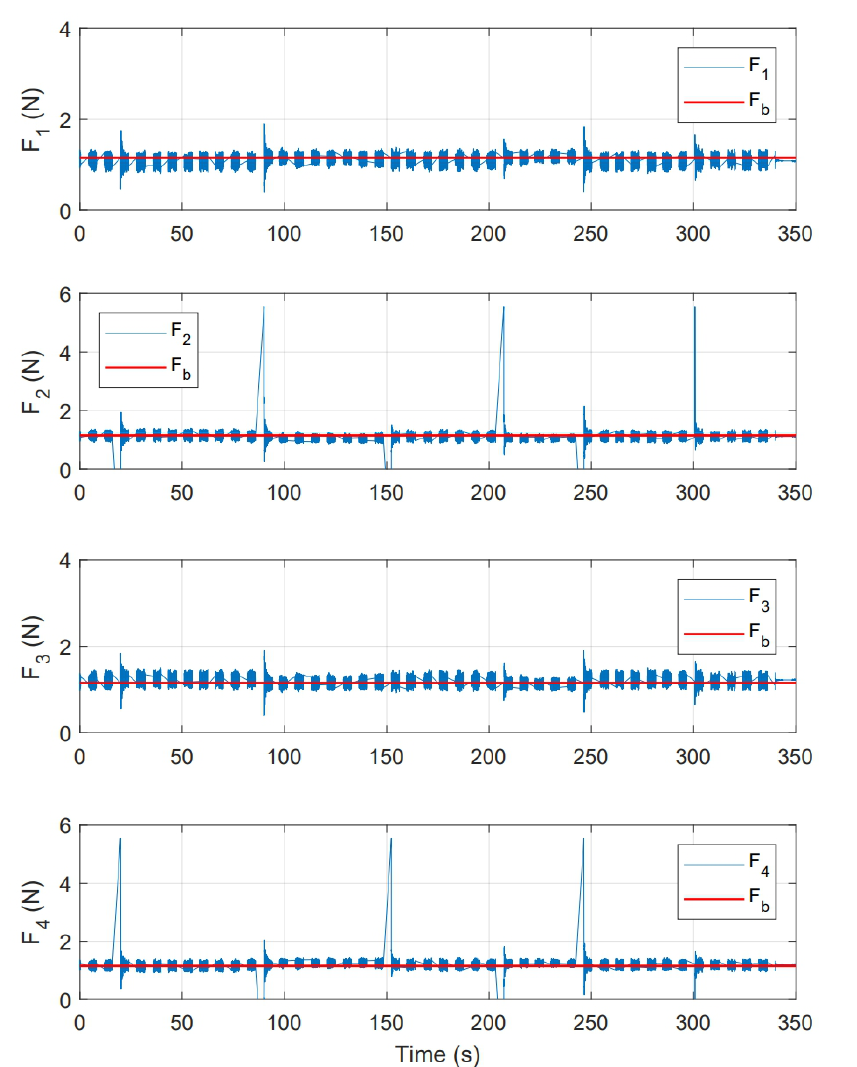
Figure 24. Thrust force presented for each motor in PID control